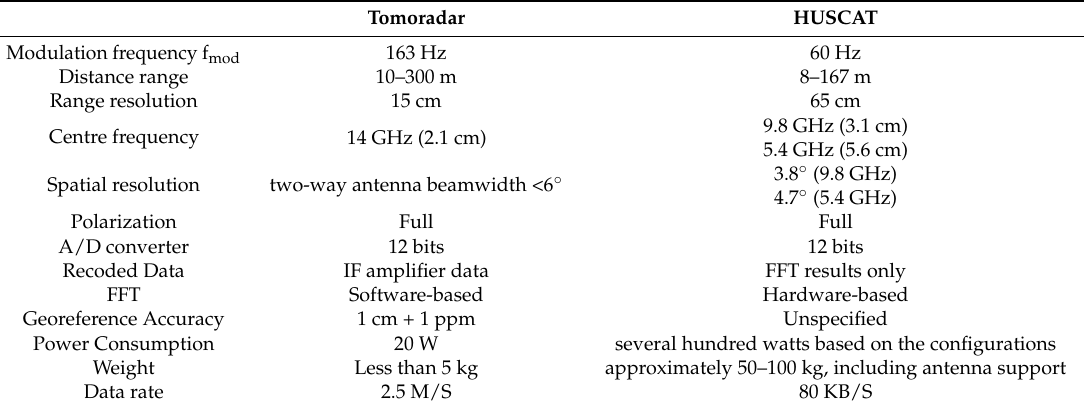
Table 1. Technical Specification Comparison between Tomoradar and